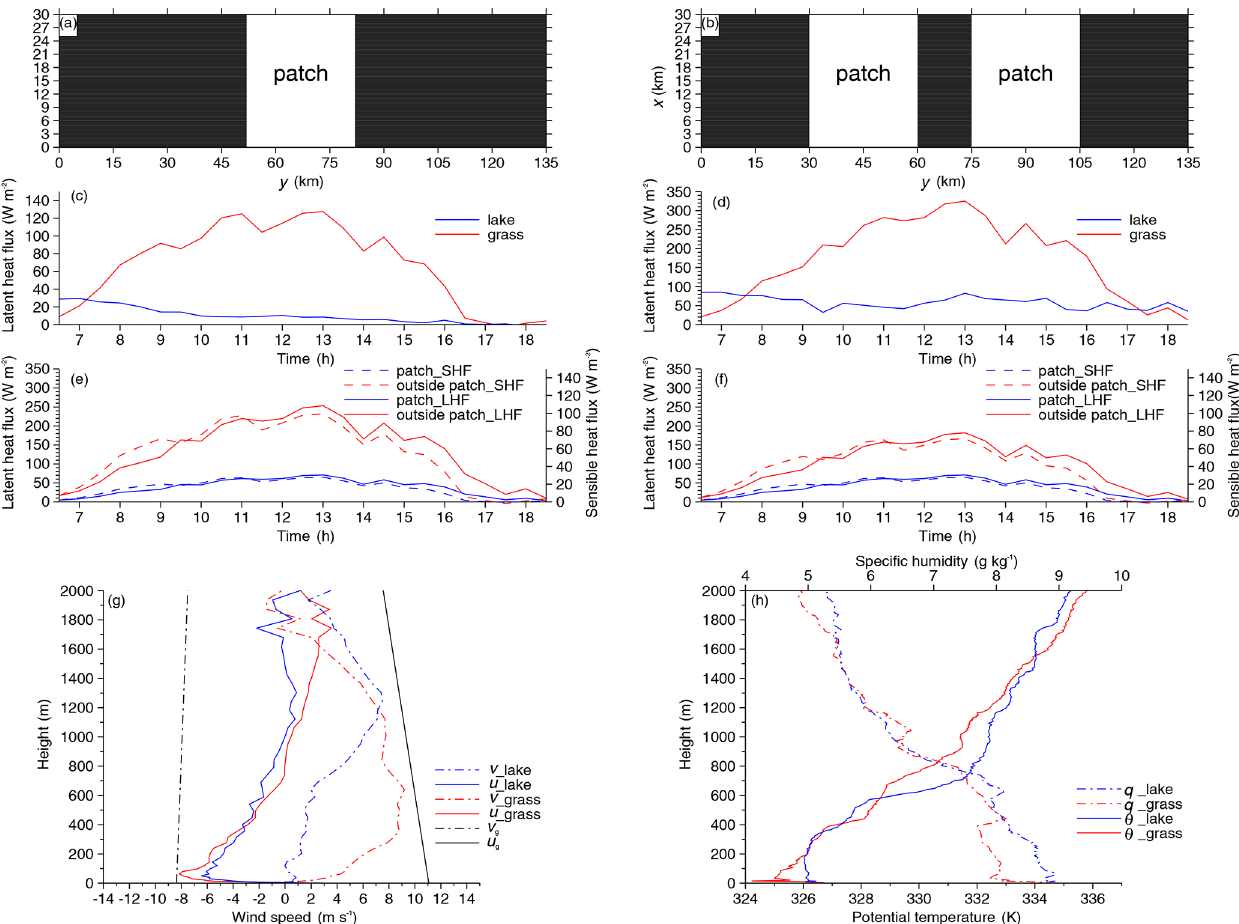
Figure 2. Sketch of the heterogeneous surface (a, b) , surface sensible heat flux and latent heat flux (c, d) over the grassland (red line) and the lake (blue line) from observation. The SHF and the LHF for runs with (e) one and (f) two lake patches and a constant heat flux. Panels (g) and (h) show the model initial profiles of the winds (solid lines for u , dashed lines for v ), potential temperature (solid lines), and special humidity (dashed lines) over the lake patches (blue lines) and outside of the patches (red lines). The input geostrophic winds are also shown (black